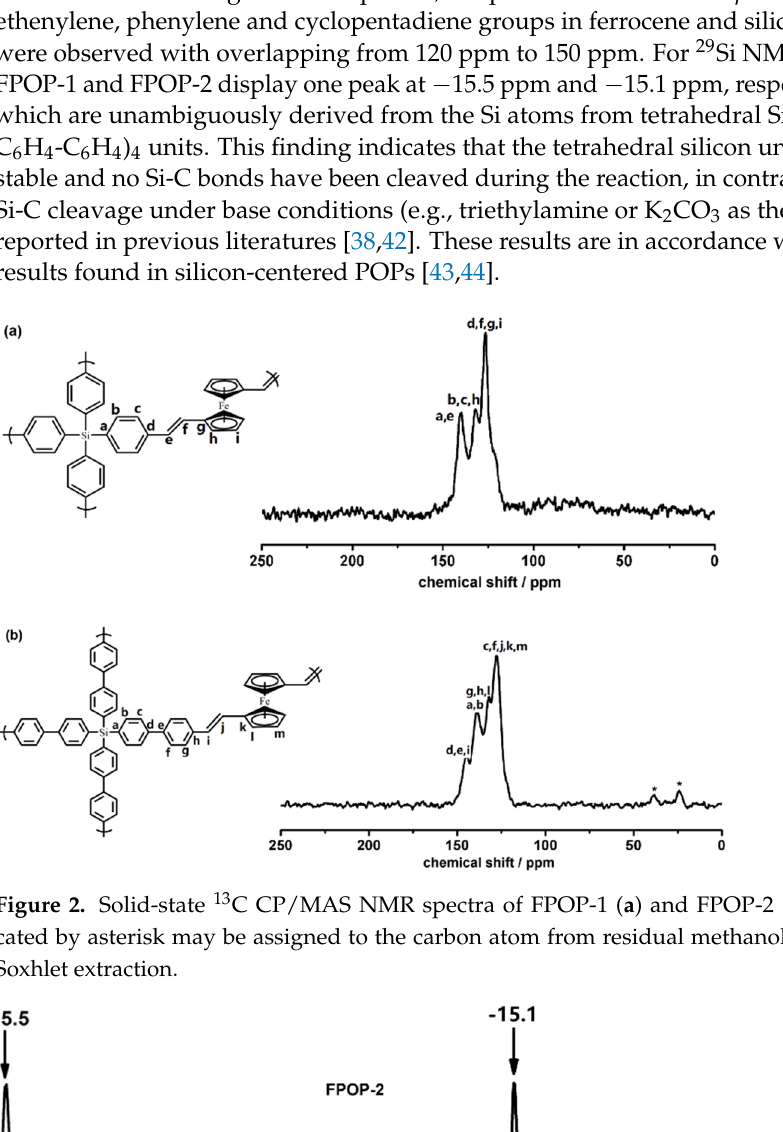
Figure 1. FT-IR of FPOP-1 and FPOP-2.